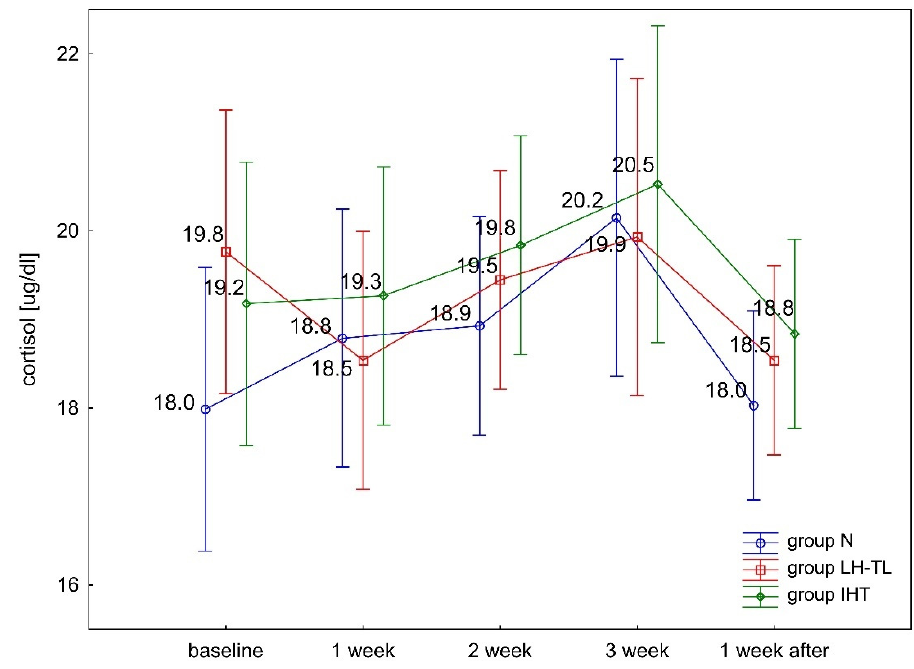
Figure 2. Blood serum cortisol levels (C) in experimental (LH–TL and IHT) and control (N1) groups during the first experiment.